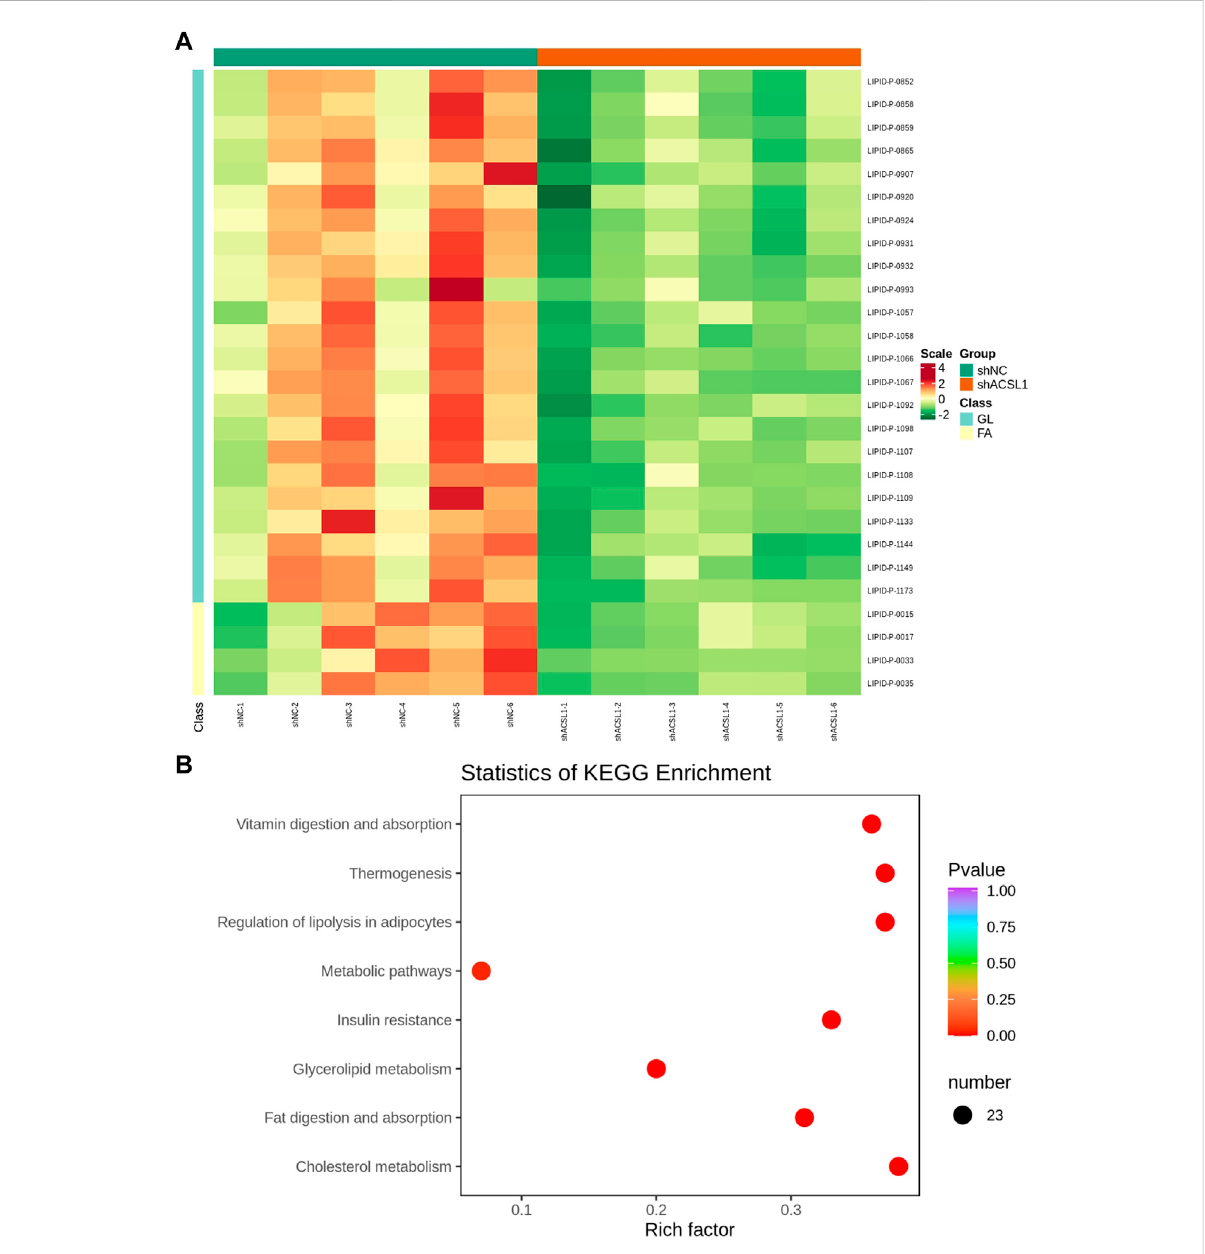
FIGURE 6 Lipid metabolome sequencing: (A) heat map; (B) KEGG analysis. shNC: adipocytes transfected with shNC as control. ShACSL1: adipocytes transfected shRNA-293 of the ACSL1